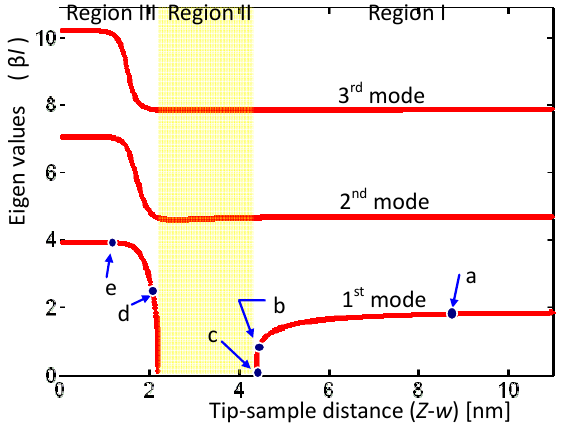
Figure 5. Relationship between first three eigenvalues and tip-sample distance.